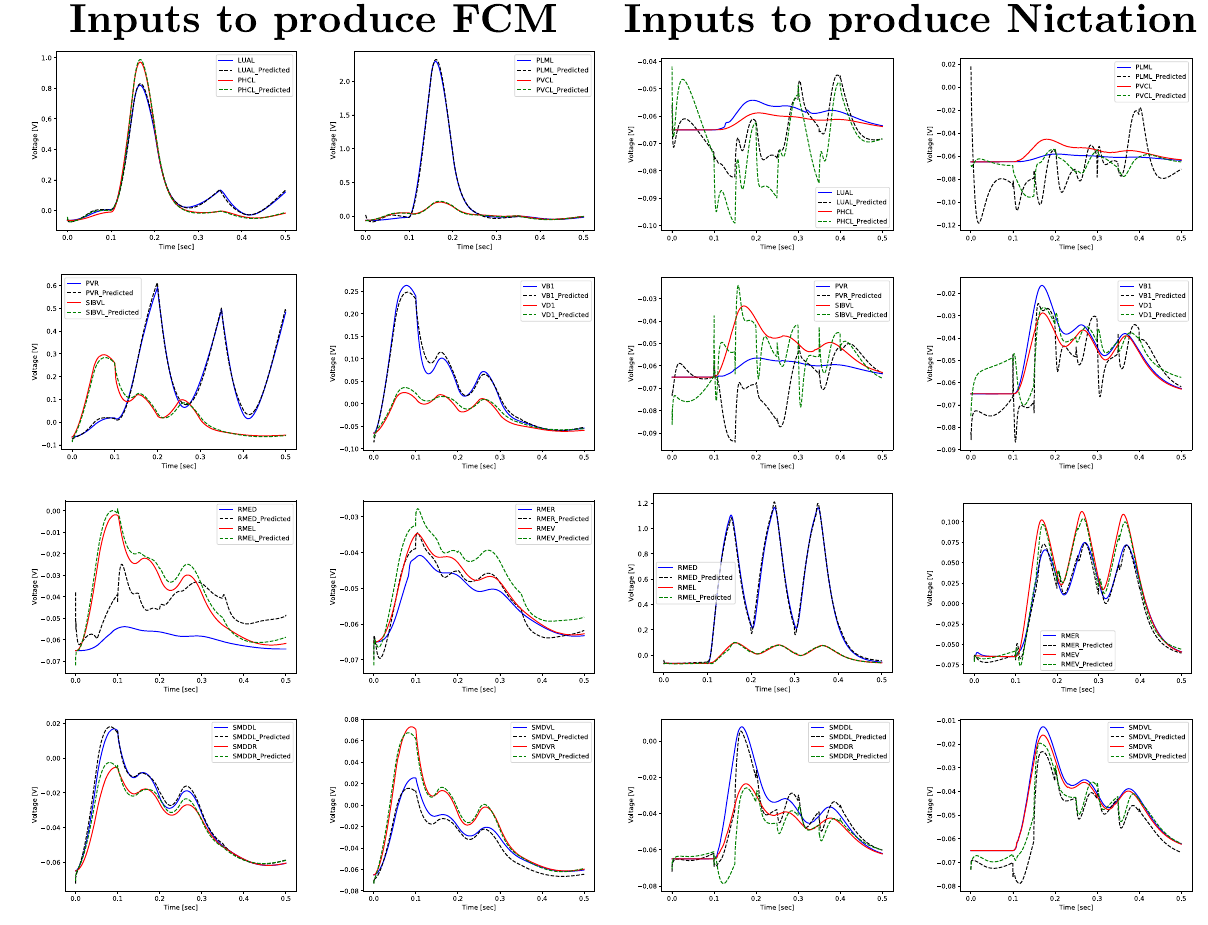
Figure 12. Experiment 5: realistic (red and blue) and predicted (green and black) sequences for various output neurons of the test set (one selected simulation out of ten) corresponding to FCM behaviour (first two rows) and Nictation behaviour (last two